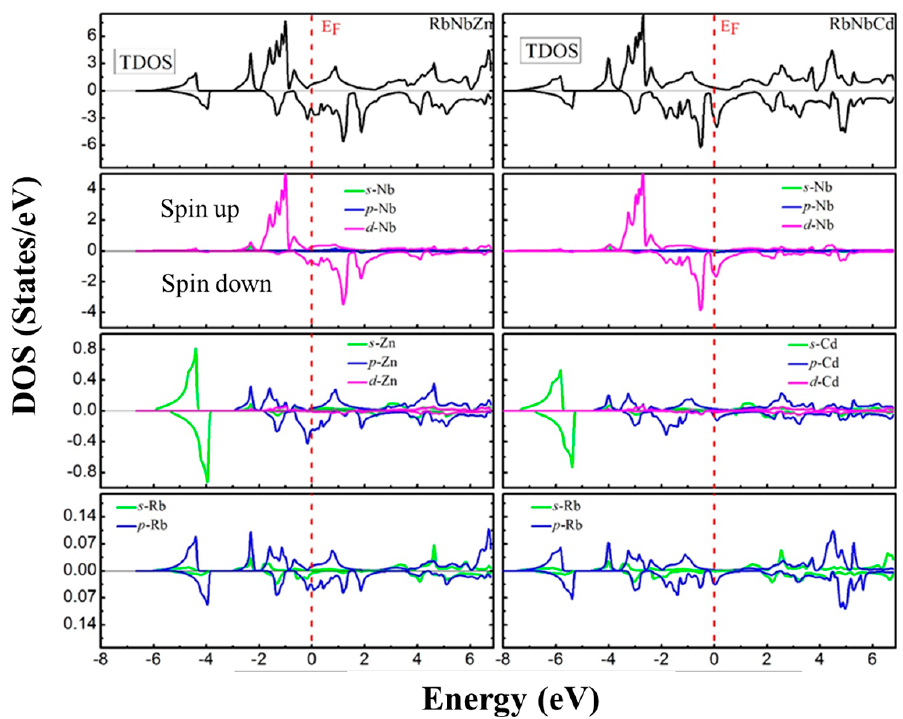
Figure 5. Calculated total and partial density of states (TDOS, PDOS) in spin up and spin-down for RbNbCd and RbNbZn.